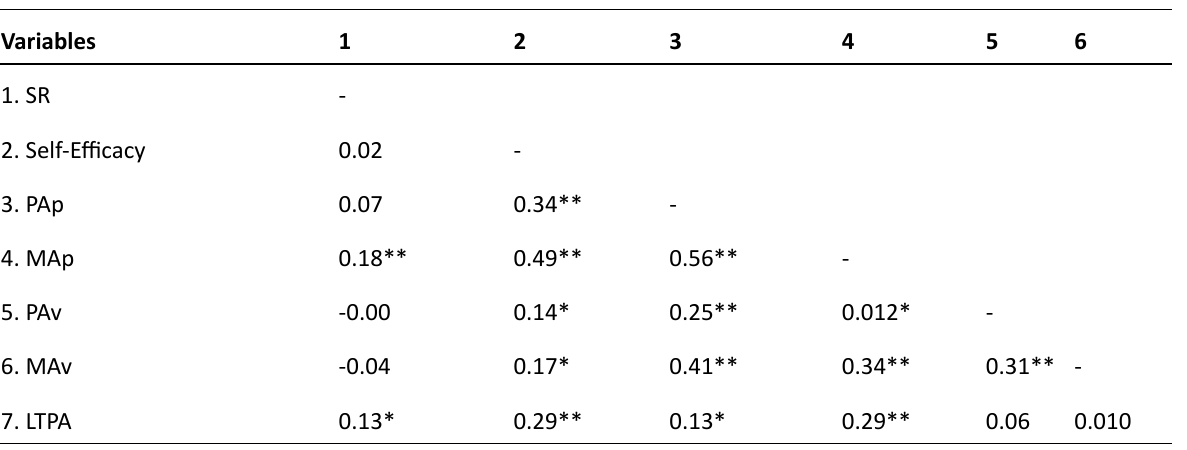
Table 3. Bivariate correlations among study